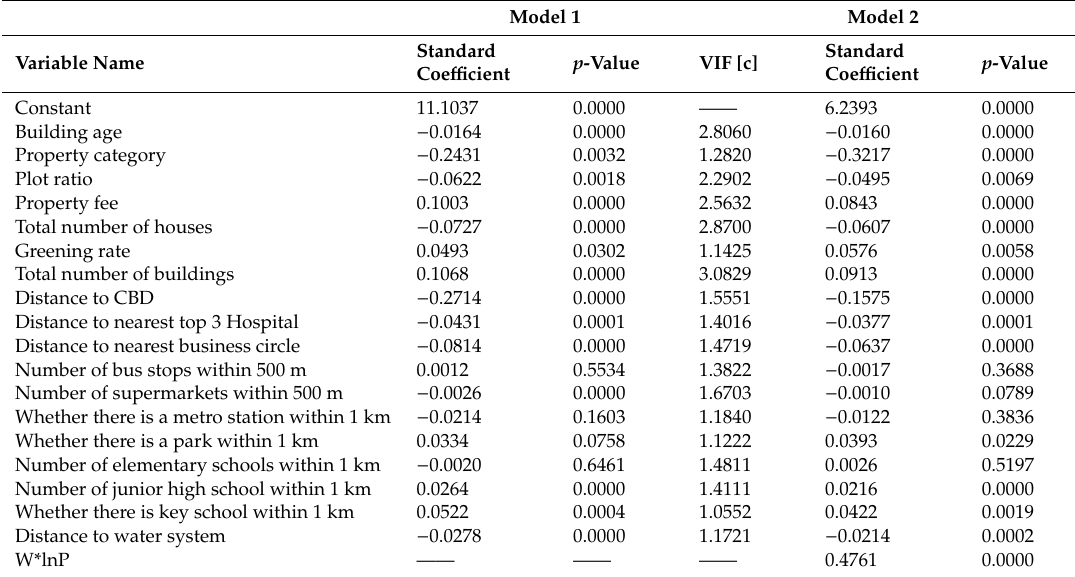
Table 5. Regression results of Models 1 and 2.